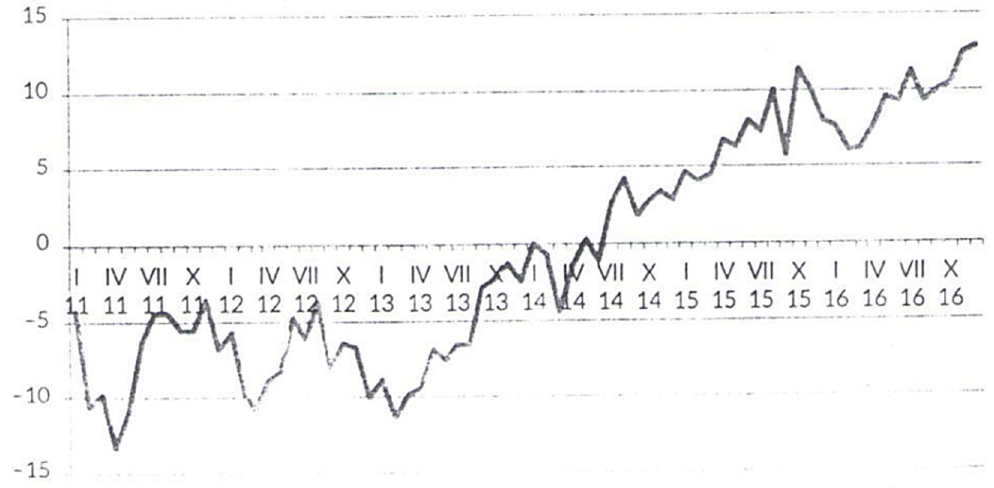
Figure 6. Financial condition of companies in the section “Transport and warehousing industry” in the period 2011 to 2016. ( Source: Main office of Statistics (GUS), 2017b.).